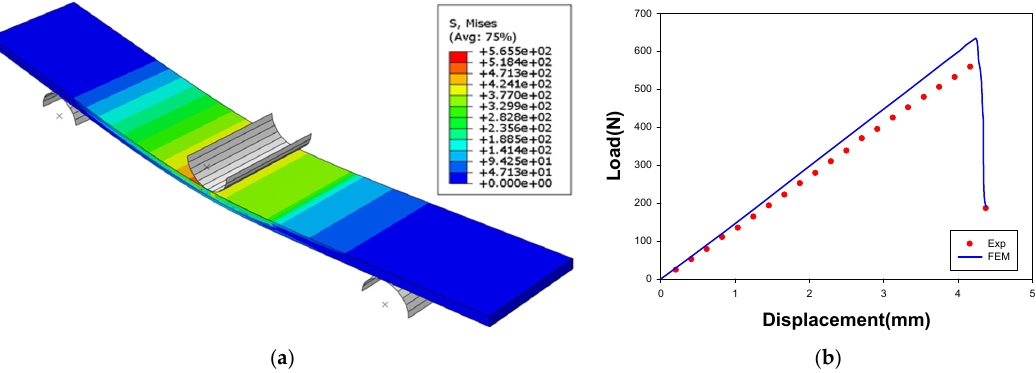
Figure 10. Result of FE simulation for the DCB test: ( a ) Distributions for effective stress; ( b ) Load-displacement curve.